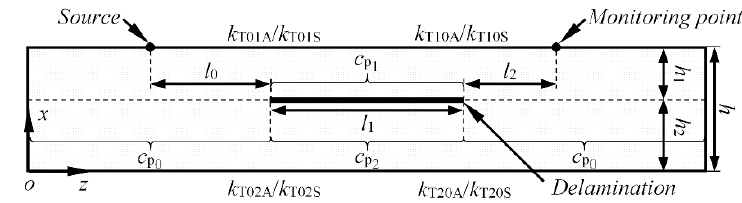
Figure 1. Schematic diagram of considered example of a composite plate with delamination-type damage.